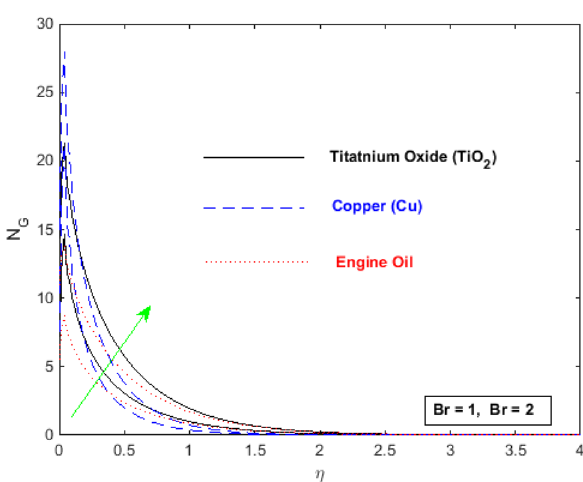
Figure 15. Entropy generation profile for B r .